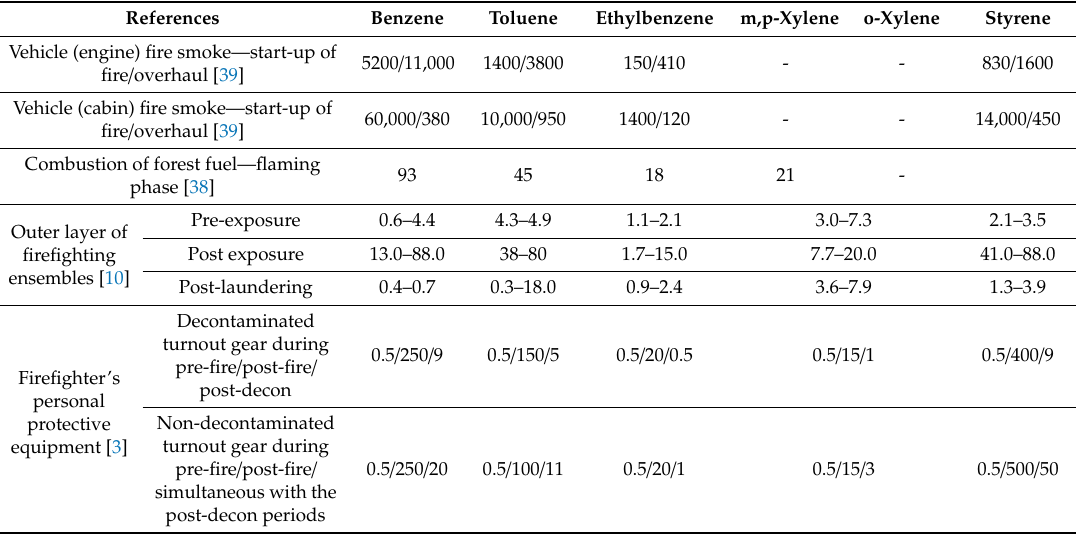
Table 4. Concentration ranges of the BTEXS compounds ( µ g / m 3 ) measured at di ff erent